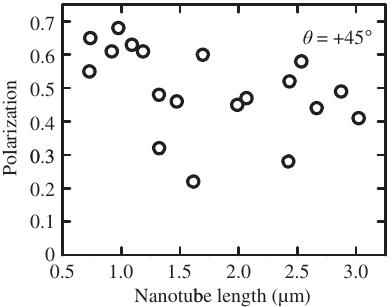
FIG. 6. Dependence of CD polarization on the suspended length of (9, 7) CNTs. Data are taken with θ ¼ þ 45 ∘ , λ ¼ 780 nm, and P ¼ 5